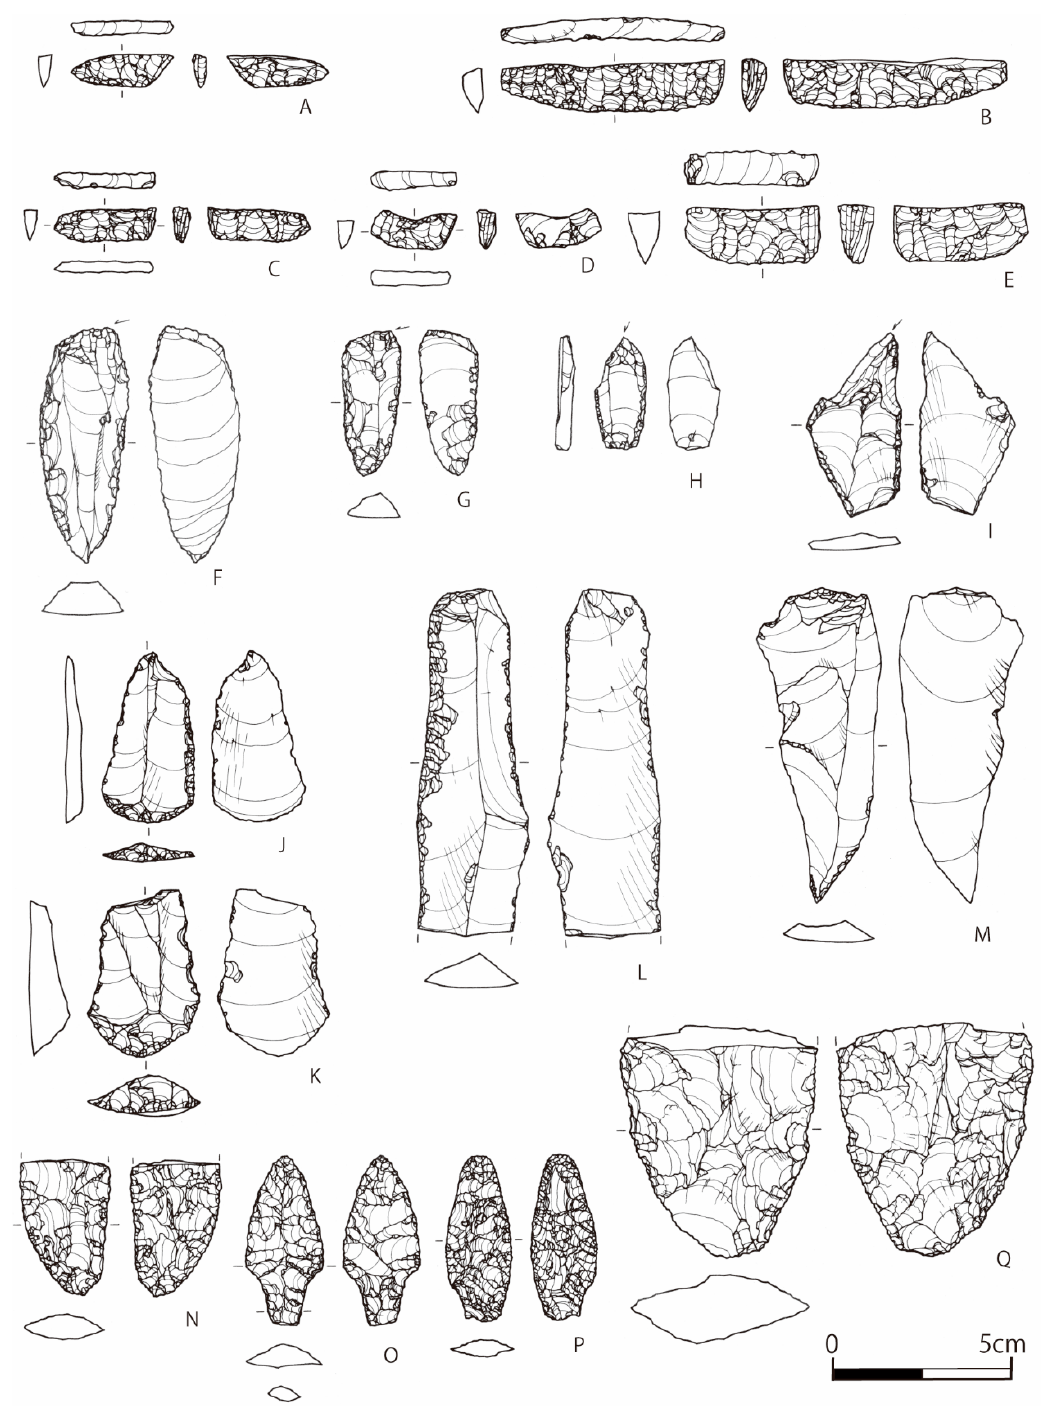
Figure 4. Stone artefacts in the boat-shaped tool techno-complex. Examples from the Nishimachi-1 site in northern Hokkaido: ( A–E ) boat-shaped tools; ( F–I ) burins; ( J , K ) end-scrapers; ( L ) side-scraper; ( M ) drill; ( N , Q ) broken bifacial points; ( O , P ) bifacial stemmed points. Reproduced from [62].